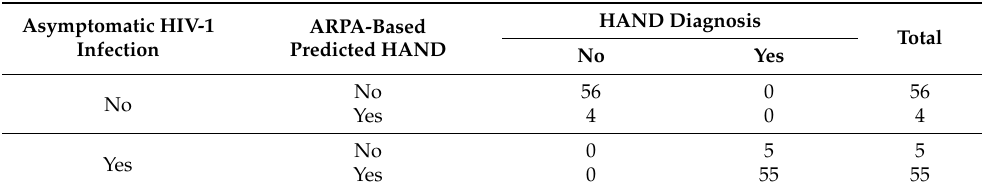
Table 3. Number of individuals with HAND based on the short screening protocol following Frascati 1SD criterion, along with the ARPA-based predicted HAND diagnosis by HIV-1 infection status. Here, age, sex, years of education, and tasks comprising our short screening protocol were included as predictors.